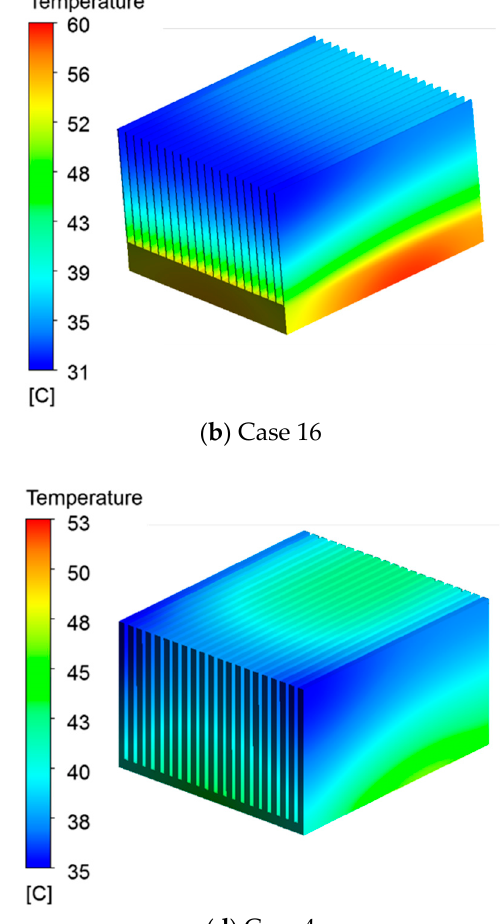
Figure 5. Temperature display of heat sinks.